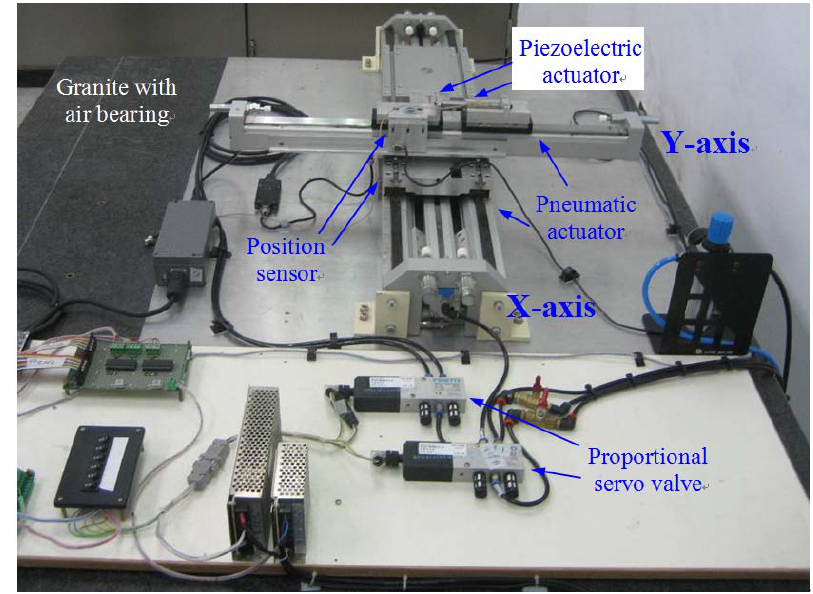
Figure 1. X-Y dual-axial pneumatic-piezoelectric hybrid actuator for position control.